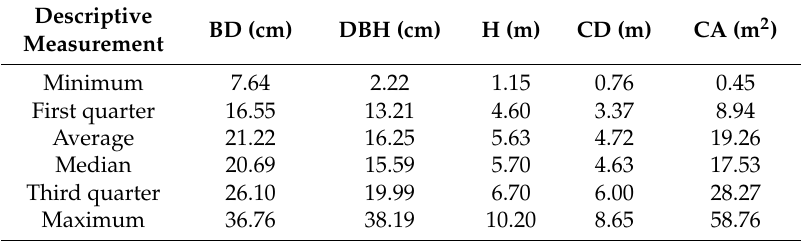
Table 2. Descriptive statistics of 117 trees from Pinus arizonica Engelm. clonal orchard.